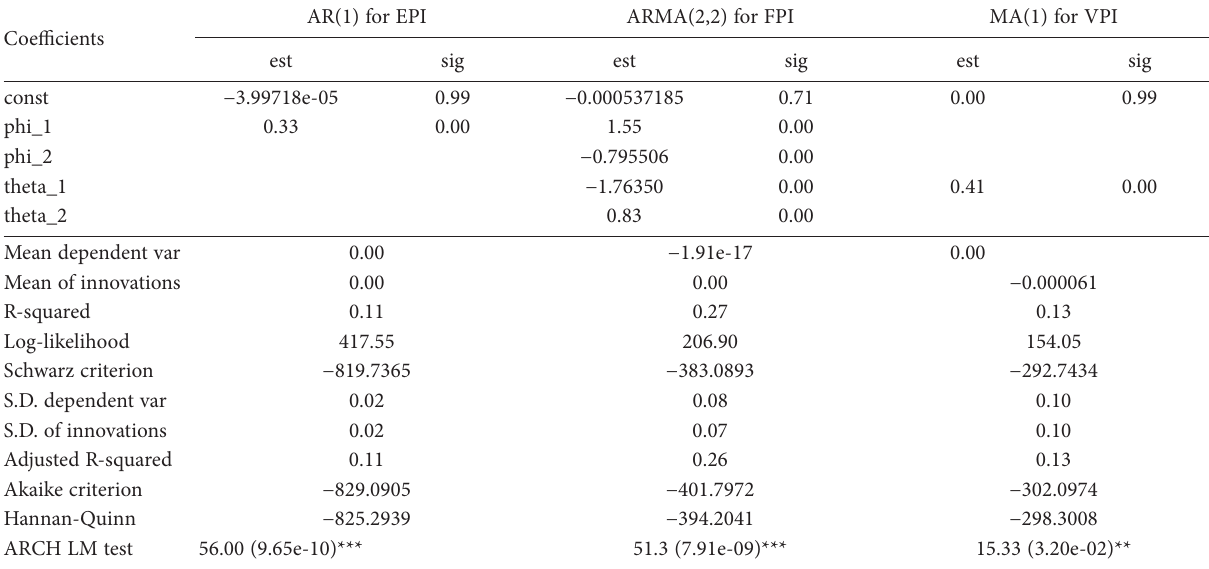
Table A3. ARMA Model Outputs for EPI, FPI and